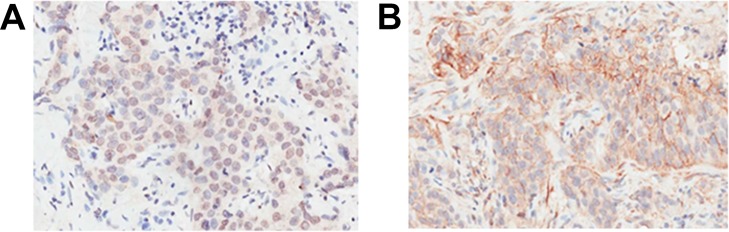
Representative images of breast cancer immunostaining for ICOSL at subcellular locations (200× magnification).(A) ICOSL was expressed primarily in the nucleus or cytoplasm. (B) ICOSL was expressed primarily in the cytoplasm or on the plasma membrane. ICOSL staining was shown as the brown color in the images.